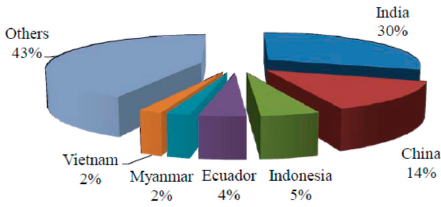
Figure 2. Percentage of bamboo produced by continent [21,30].